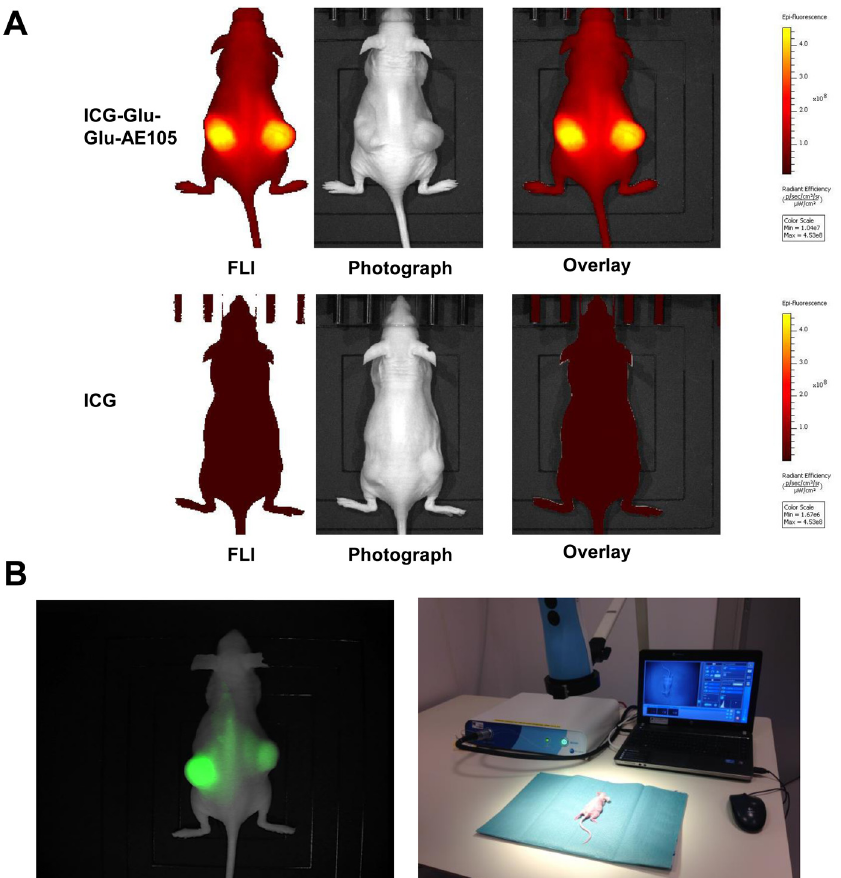
Fig 3. Optical images of tumor bearing mice with ICG-Glu-Glu-AE105 or ICG. (A) Representative optical images of U87MG tumor bearing mice from both groups 15 h post injection (ICG-Glu-Glu-AE105 and ICG) obtained with the IVIS Lumina XR. The images show clear difference in the fluorescent signal from the s.c. tumors with 3.52 ± 0.17 and 1.04 ± 0.04 respectively. The images are shown within the same scalebar to allow for direct comparison. (B) Image from the Fluobeam 1 800 and the Fluobeam setup. A Fluobeam image of a representative mouse with s.c U87MG tumors. The difference in intensity of the two tumors is a result of size of the tumors and the optical properties of the camera. The representative image from the fluobeam camera shows similar signal as the black-box imager IVIS Lumina XR. This underlines the translational potential of